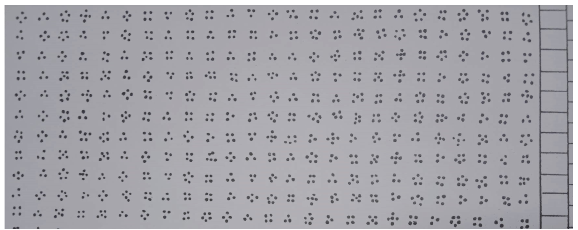
Figure 3. Example of the WP test (part of the sheet used for WP